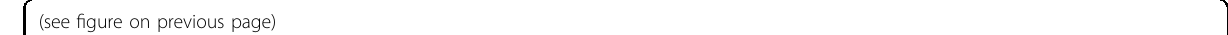
Fig. 3 CXCR4 regulates DR5 transcription by differentially modulating the recruitment of transcription factors p53 and YY1 at the promoter site of DR5. A Western blot analysis of DR5 in control and CXCR4 overexpressing MCF-7 cells after ba fi lomycin or MG132 treatment for 5 h; β -actin was used as the protein loading control. B , C Total RNA was isolated from CXCR4 overexpressing (MCF-7) and knockdown (HT-29) stable cells along with their respective controls and reverse transcribed. Fold change in DR5 mRNA expression was measured by RT-qPCR as described in Materials and Methods. Data are representative of three independent experiments, resulting from duplicate readings of two different samples; Columns, average value of DR5 mRNA expression; bars ± SEM. *, p < 0.05, compared with respective controls. D Western blot analysis of p53, YY1, and Sp1 in control and CXCR4 overexpressing MCF-7 cells; GAPDH or β -actin was used as the protein loading control. Western Blot densitometric quanti fi cation numbers are shown above the loading control blot of all immunoblot studies. E Fold change in mRNA expression of p53, YY1, and Sp1 in control and CXCR4 overexpressing stable MCF-7 cells was assessed by RT-qPCR; Columns, average value of p53/yy1/sp1 mRNA expression; bars ± SEM. *, p < 0.05, compared with respective control. F Diagrammatic representation for the p53 binding on activator site as well as YY1 binding on repressor site of the DR5 gene promoter region. G , H ChIP assay for the analysis of YY1 and p53 recruitment on the DR5 gene promoter in CXCR4 overexpressing and control stable MCF7 cells followed by RT-qPCR. Fold change in p53 and YY1 recruitment on the respective activator and repressor sites of the DR5 gene promoter were assessed in control and CXCR4 overexpressing MCF-7 cells. Results are representative of at least two independent experiments; Columns, an average of duplicate readings of samples; error bars ± S.D. * p < 0.05 versus control MCF7